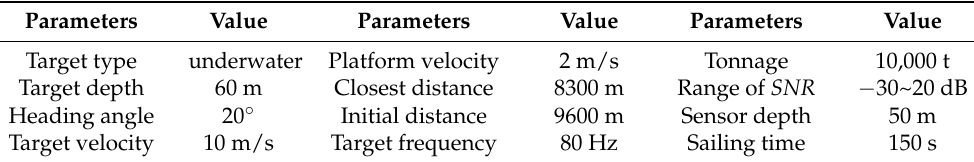
Table 3. Target simulation parameters of the underwater target.